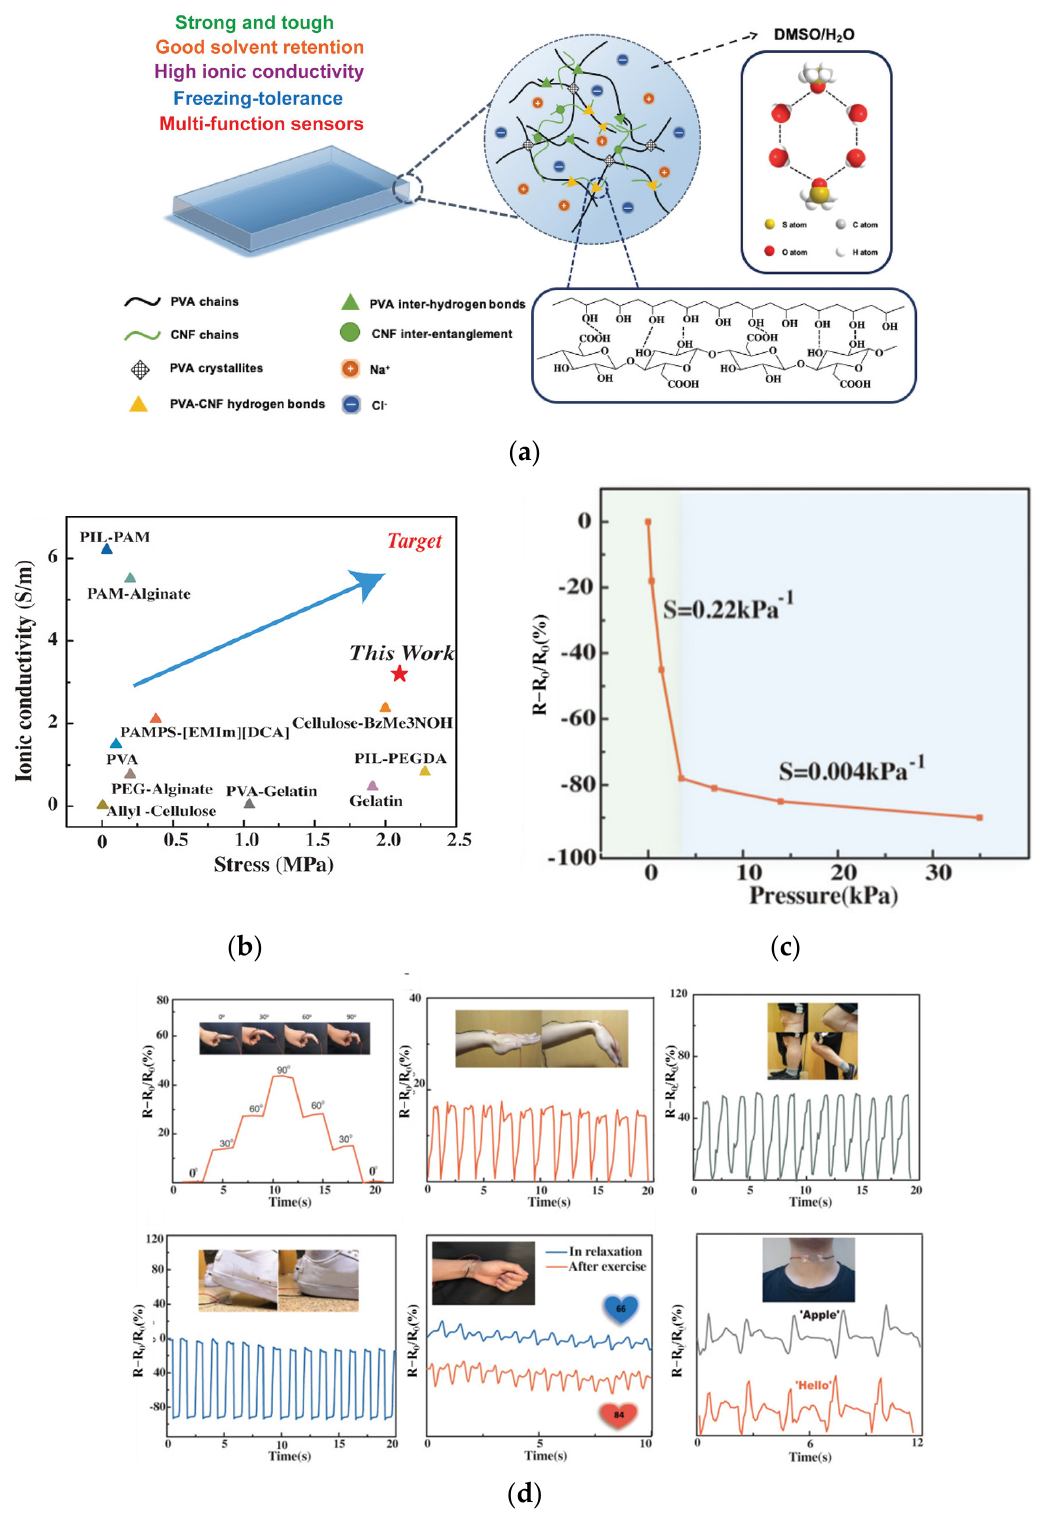
Figure 5. Cellulose-based ionic conductive hydrogel for multi-functional sensors. ( a ) Schematic illustration of PVA-CNF organohydrogel. ( b ) Ashby plot of ionic conductivity and tensile stress with other reported ionic conductive (organo) hydrogels. ( c ) Relative resistance changes and pressure sen- sitivity of PVA-1%CNF organohydrogels-based sensor at varying pressure. ( d ) The relative resistance changes of sensors versus time for real-time monitoring of various human motions. Adapted with permission from Ref. [131], WILEY-VCH Verlag GmbH & Co. KGaA,